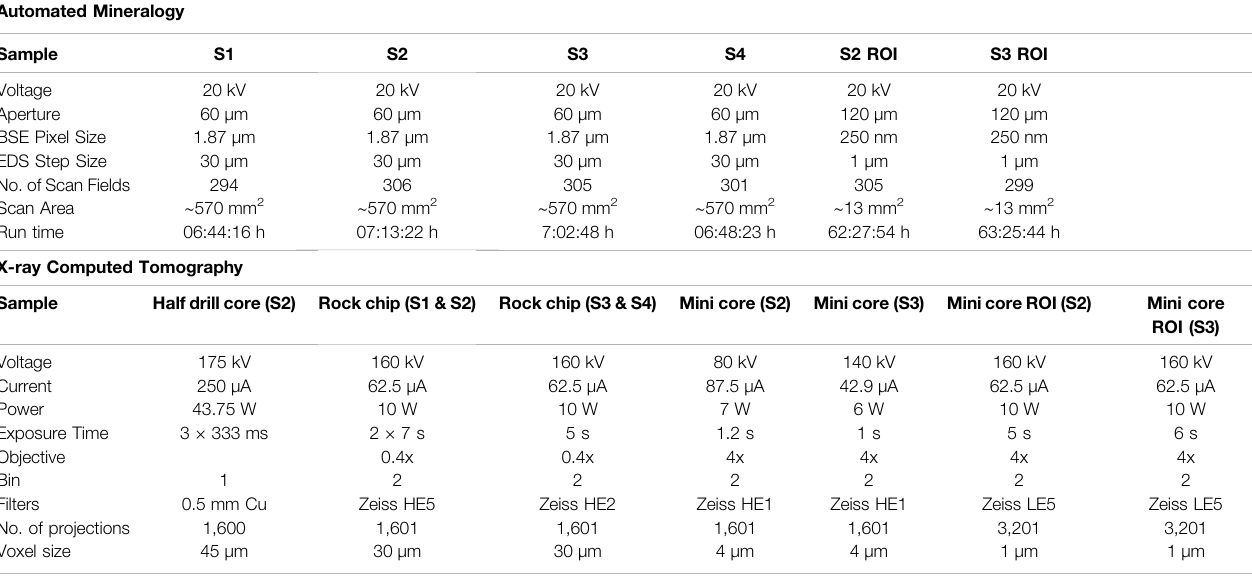
TABLE 1 | Experimental conditions of AM and XCT. For XCT analysis, the half drill core piece was analyzed on a GE phoenix v|tome|x s at GTK, Espoo, Finland. All other samples were analyzed on a Zeiss Xradia 510 Versa at LTU, Luleå,